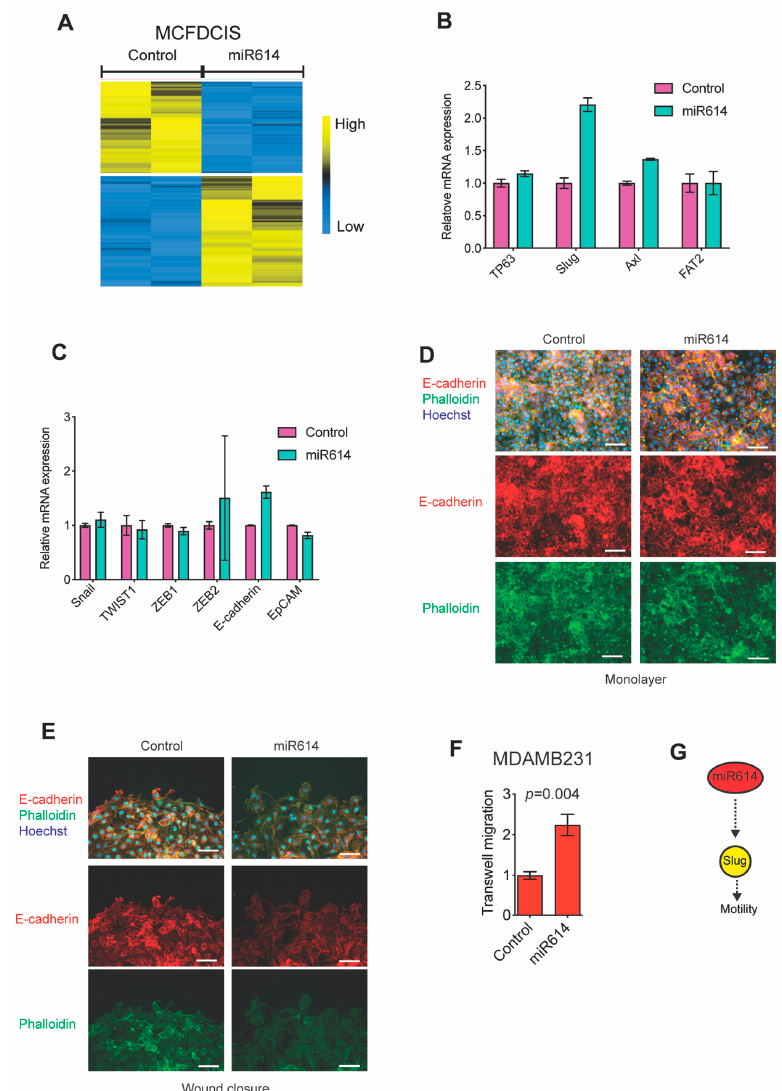
Figure 2. miR614 induces Slug expression. ( A ) Heatmap showing how miR614 alters gene expression in MCFDCIS cells. Biological replicates are shown. Yellow indicates increased expression and blue indicates reduced expression. ( B ) Graph shows how miR614 influences the expression of genes that have previously been shown to be required for MCFDCIS cell migration. ( C ) Graph shows how miR614 influences the expression of epithelial-to-mesenchymal transition (EMT) inducing transcription factors and the epithelial genes E-cadherin (CDH1) and EpCAM. ( D ) Representative images of confluent MCFDCIS cells 72 h after transfection. Cells were immunostained with anti-E- cadherin antibody (red) and counterstained with Hoechst (blue, nuclei) and phalloidin (green, F-actin). Scale bars, 50 µ m. ( E ) Representative images of migrating MCFDCIS cells after wounding. Cells were transfected as indicated, immunostained with anti-E-cadherin antibody (red) and counterstained with Hoechst (blue, nuclei) and phalloidin (green, F-actin). Scale bars, 25 µ m. ( F ) miR614 increases the transwell migration of MDAMB231 cells. MDAMB231 cells were transfected with control or miR614 mimic for 48 h and then re-plated onto transwell inserts in serum free media. Transfected cells were then allowed to migrate towards serum containing media for 24 h. Graph shows the number of cells that migrated through the insert divided by the total number of cells on the top and underside of the insert and normalized to the control. Mean ± SD of 3 independent experiments. p -values determined by unpaired Student’s t -test. ( G ) Model showing that miR614 increases the expression of Slug and cell